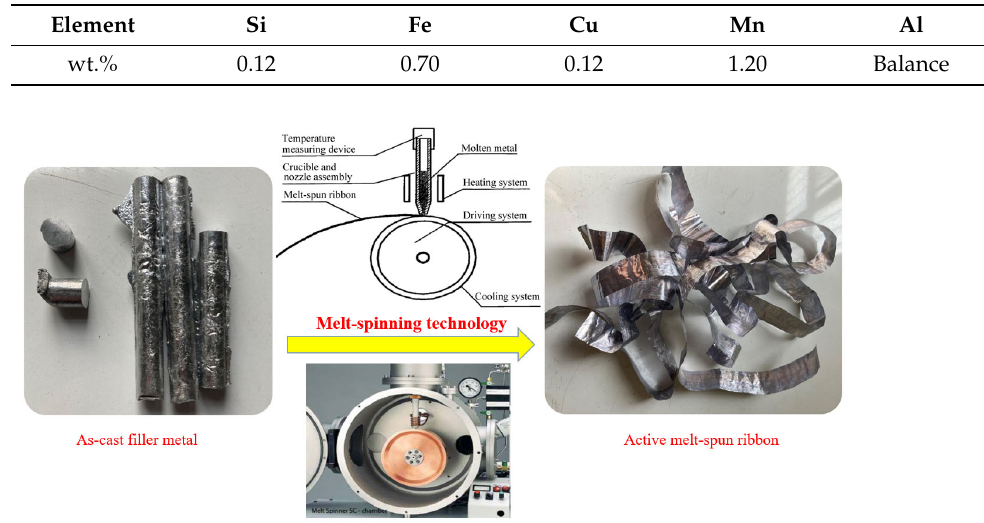
Table 1. Chemical composition of 3003 aluminum alloy used in heat exchanger (in wt.%).